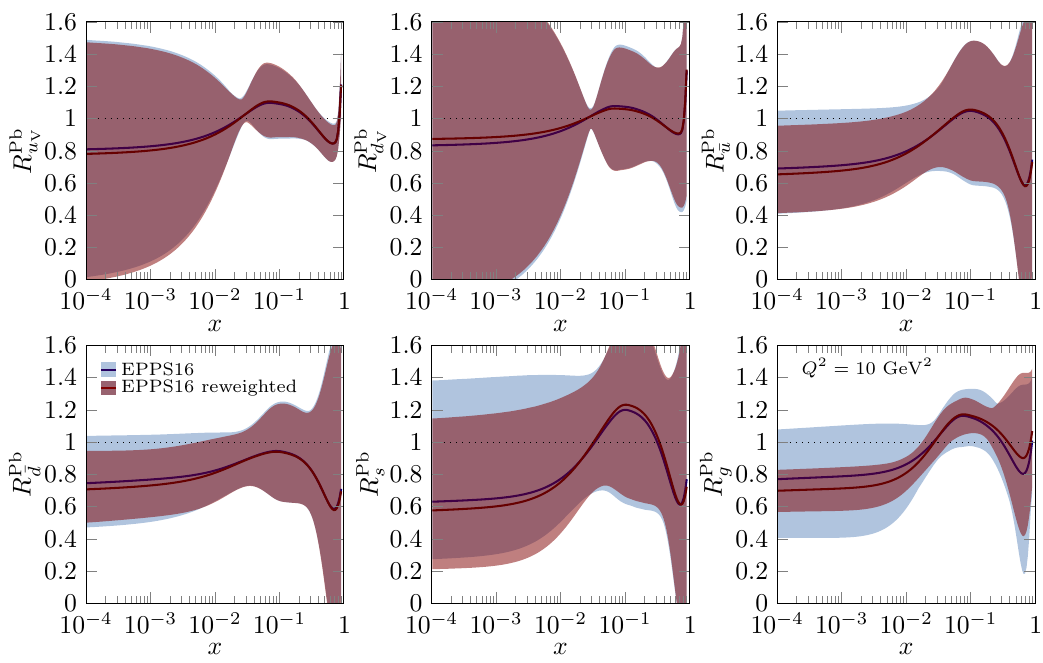
Figure 9 . The EPPS16 nuclear modi(cid:12)cations for bound-proton PDFs in Pb nucleus before (blue) and after (red) reweighting with the LHCb data. The scale is Q 2 = 10 GeV 2 .